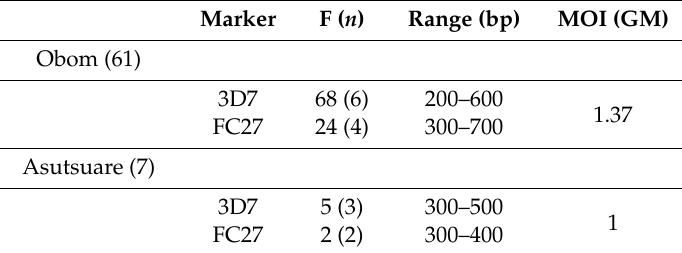
Table 2. Genetic diversity within Block 3 of Msp2.